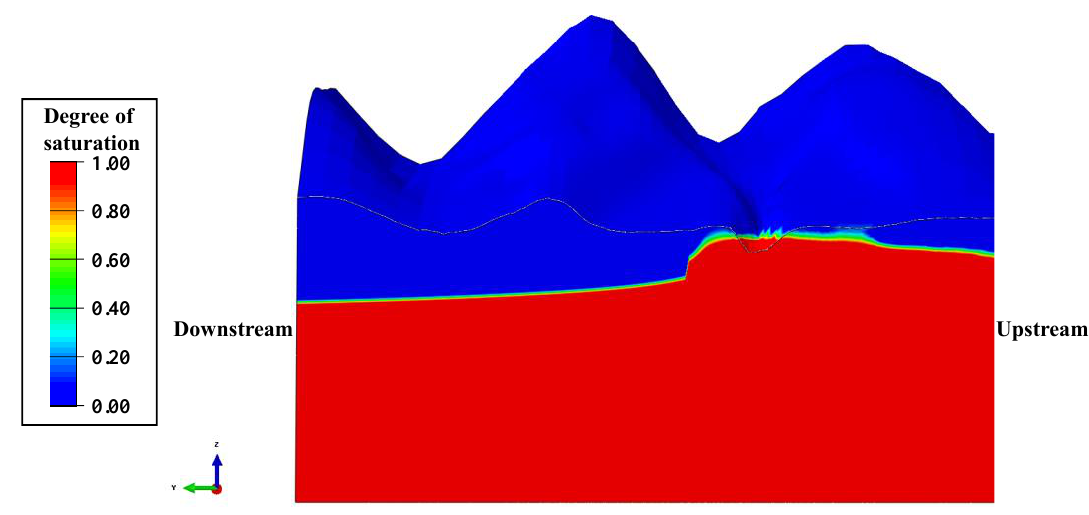
Figure 21. Numerical calculation results of rock-mass saturation in the right bank